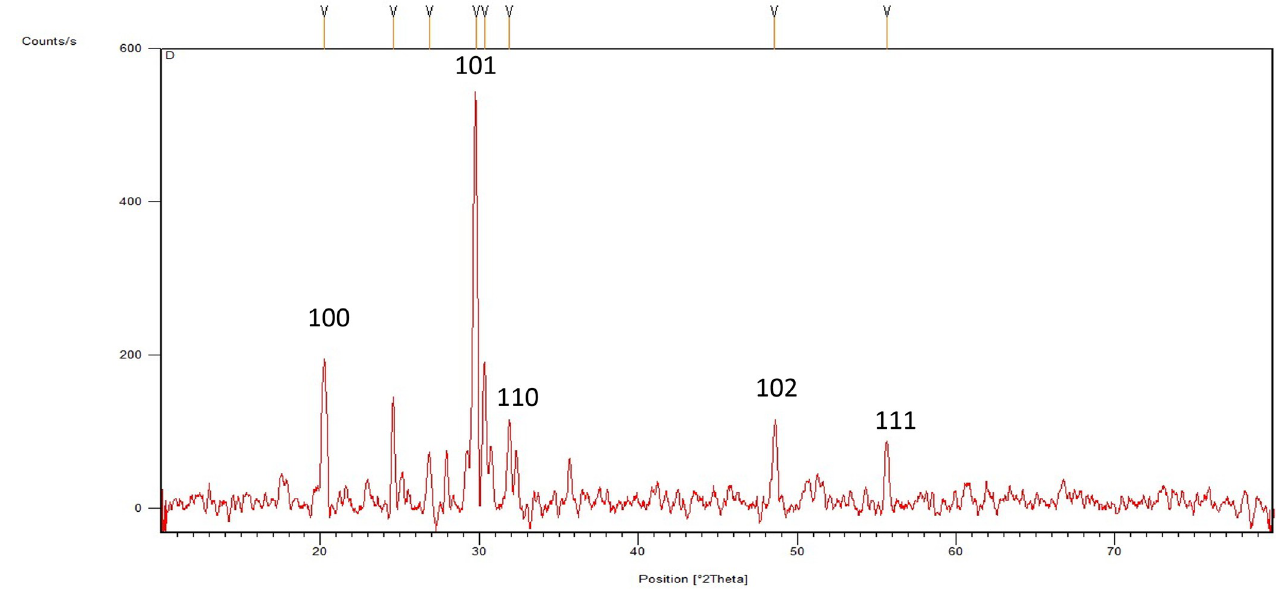
Fig 4. XRD diffractogram of the green synthesized SeNPs.